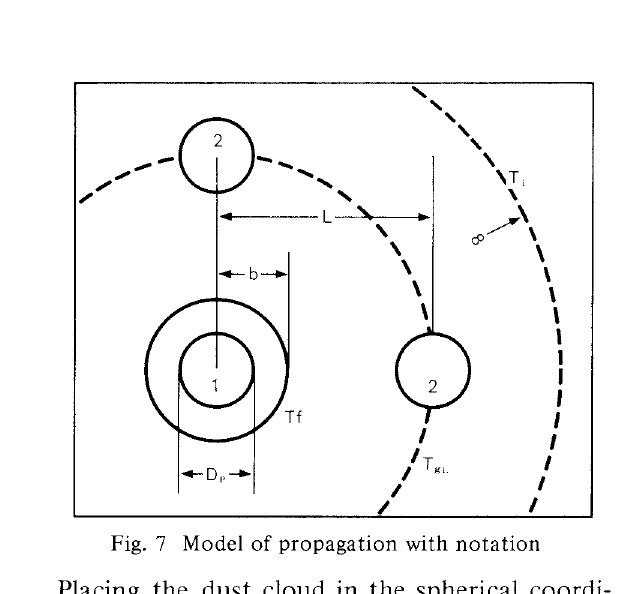
Fig. 7 Model of propagation with